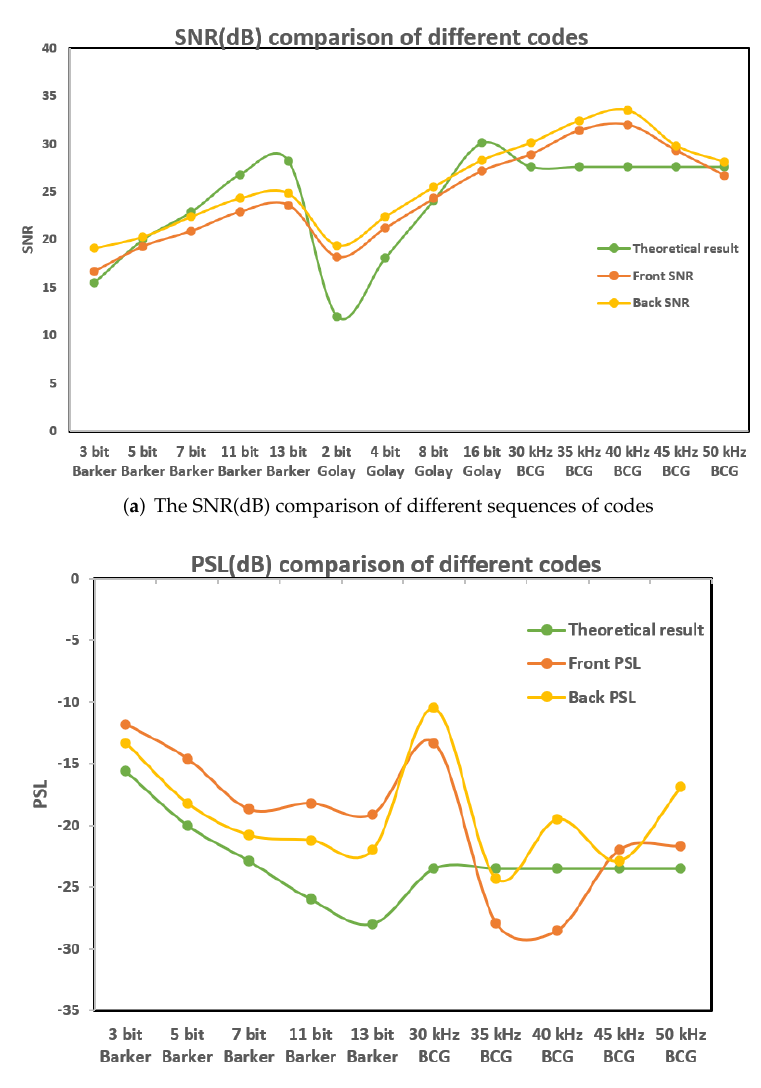
Figure 10. Comparison of SNR and PSL (dB) results ( a ) Comparison of the theoretical SNR results from Figure 5, front side SNR results and back side SNR results ( b ) Comparison of theoretical PSL results from Figure 4, front side PSL results and back side PSL